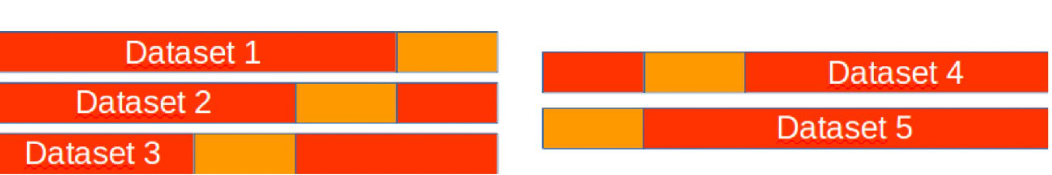
Figure 2. Schematic representation of the dataset splitting for learning (red) and testing Next, the luminosity, contrast, shadow, reflection, and saturation were settled up at 80, 100, 0, 0, and 100%, respectively, using window 7 familial edition; see Fig. 1 for the flow chart. Drawing pictorial identification key using WIPs pictures. The color patterns (blue, red, yellow) were drawn from enlarged image layers of the WIPs. The layers were scanned, and colors were added using the "top color filling" option of the free software GIMP version 2.10.30 (Available from: https:// www. gimp. org) 21 . Image pre‑processing, WIPs dataset splitting for training and testing. The WIPS dataset, which consisted of 5516 pictures of dipterann insects WIPs, including 1766 pictures of Glossina, is available on request for glossina images. The link is provided in the Additionnal information section Specimens genus was not considered to build the training and test datasets. All non- Glossina images were discarded from this publicly available dataset. Under-sampled species or subspecies (less than 10 samples) are also discarded to prevent over- fitting. Images were resized to 256 and 116 pixels for width and height, respectively. Pixel values were normalized within the (0, 1) range 22 . The dataset was then prepared for k-fold cross-validation, with k = 5 (Fig. 2). The data- set was randomly shuffled and partitioned into k equal-size subsets with similar class distributions. A separate model was evaluated for each subgroup using this subset for validation and the remaining k − 1 as training data (Fig. 3). This strategy allowed measuring the mean accuracy of 5 distinct models and was the most accurate neural network performance estimation method. Training the neural network. To automatically classify tsetse species and subspecies with the aforemen- tioned dataset, the original MobileNet 23 , ResNet 24 , and YOLOv2 25 architecture were considered. To consider the smaller size of the database as compared to classic DL databases like Imagenet, a smaller architecture was devel- oped for image recognition and classification. The first architecture inspired from MobileNet takes advantage of depth-wise convolution 23 . Our architecture uses one less scale (the scale with 1024 filters was not used) and one depth-wise convolution per scale, compared to MobileNet, which had 2 depth-wise convolutions. We used batch normalization 26 to speed up and stabilize training.